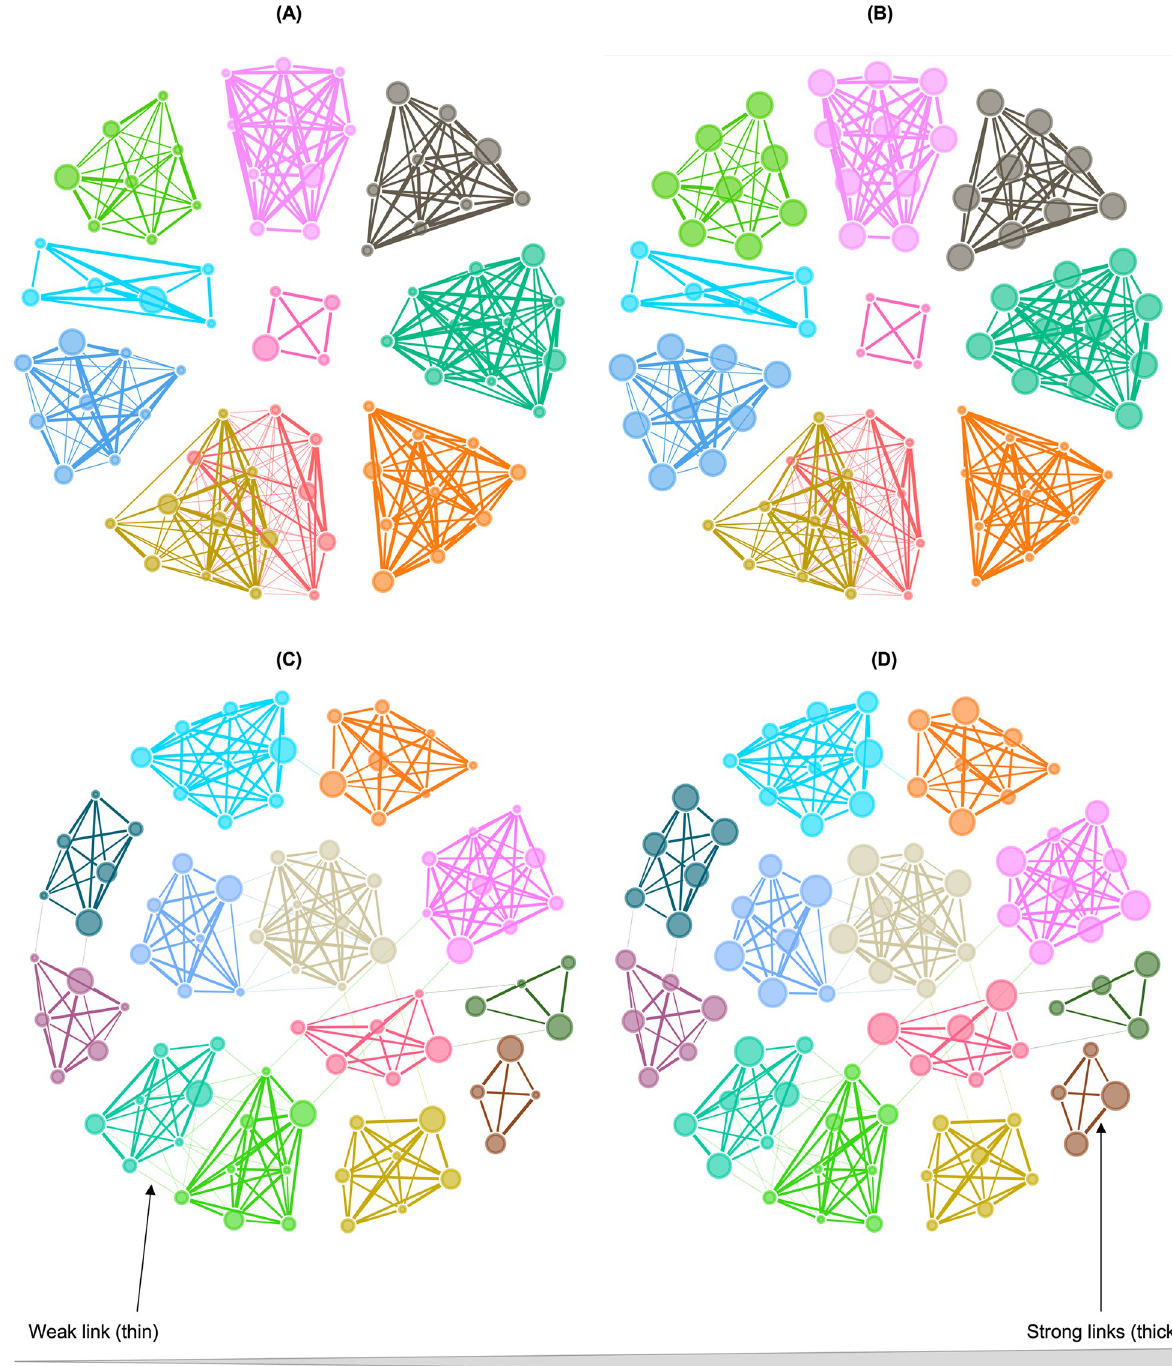
Fig 3. Social network graphs of the empirically based population with color partitioning according to a core group, considered from the perspective of either (A) age category or (B) betweenness centrality; and a comparable example of a virtual population with the partitioning according to a core group, and either (C) age category or (D) betweenness centrality. The nodes are ranked by size where the largest nodes indicate oldest age or highest betweenness centrality. The links are color coded to match the nodes they originate from and ranked according to their relative weight. The thickness scheme depicting the weight of each link ranges from thin (low) to thick (high weight). The links with weight less than 5 percent were filtered out for visual clarity.